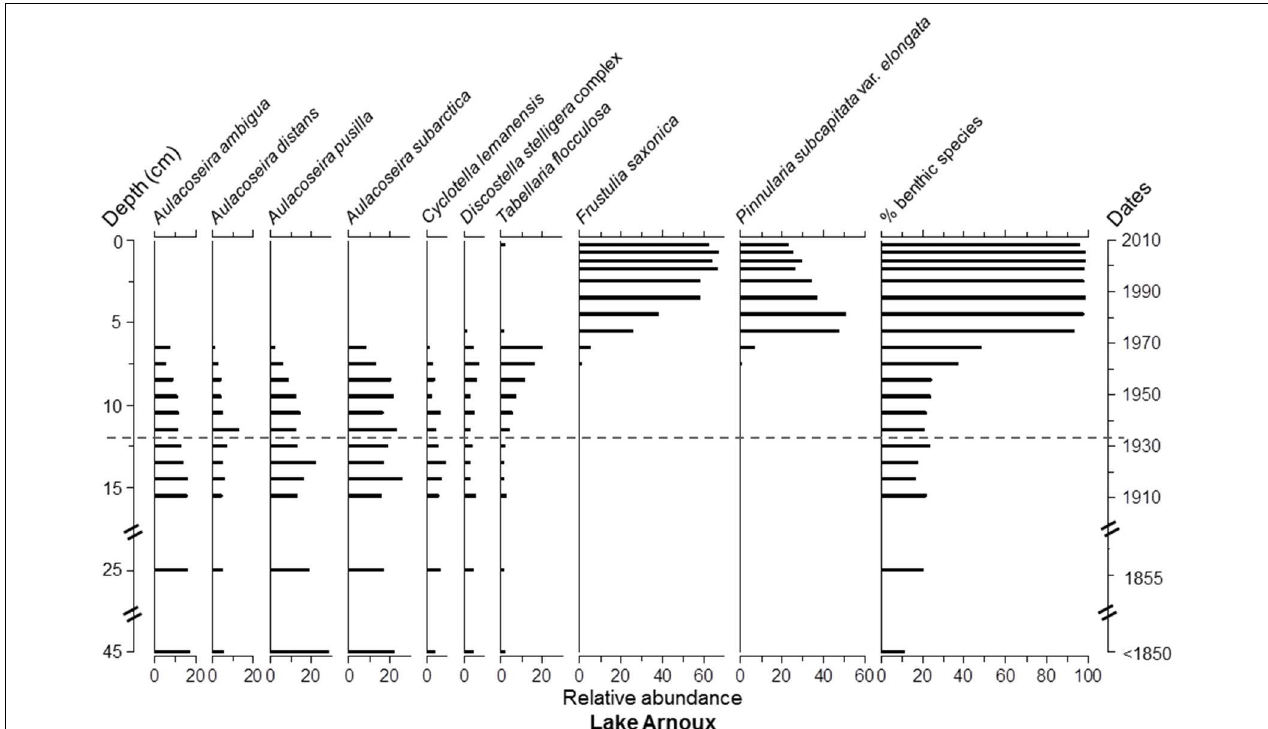
FIGURE 5 | Diatom taxa paleolimnological profiles represented as % abundance in the benthic sediments of Lake Arnoux.